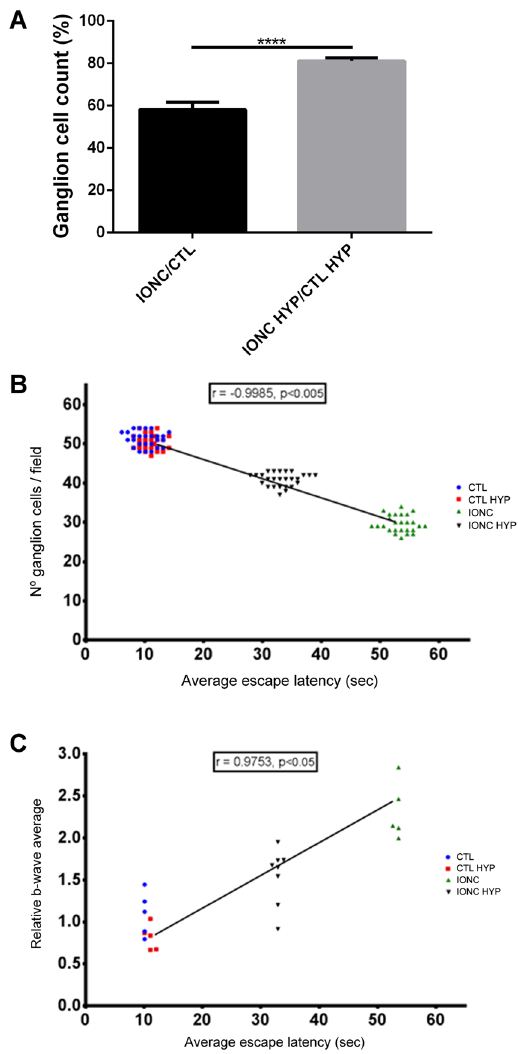
Figure 5. Variations in the number of RGCs and correlations between the average escape latency and the number of RGCs or the b-wave. ( A ) Number of ganglion cells per 25x objective microscopic field in the retina was determined and is represented as a ratio between the IONC-operated eye and its sham control. Hypothermia greatly reduced the destruction of RGCs. Bars represent the mean ± SD of all samples (n = 16 animals per group). Asterisks represent statistically significant differences. **** p < 0.0001. ( B ) Correlation study between the escape latency as measured in the modified water maze and the number of RGCs per microscopic filed. A highly significant correlation was detected with animals having more RGCs taking shorter times to find the escape platform. ( C ) Correlation study between the escape latency and the modification in the b-wave pattern observed by electroretinography. A significant positive correlation was detected with animals taking longer to find the escape platform having a more irregular electrophysiological